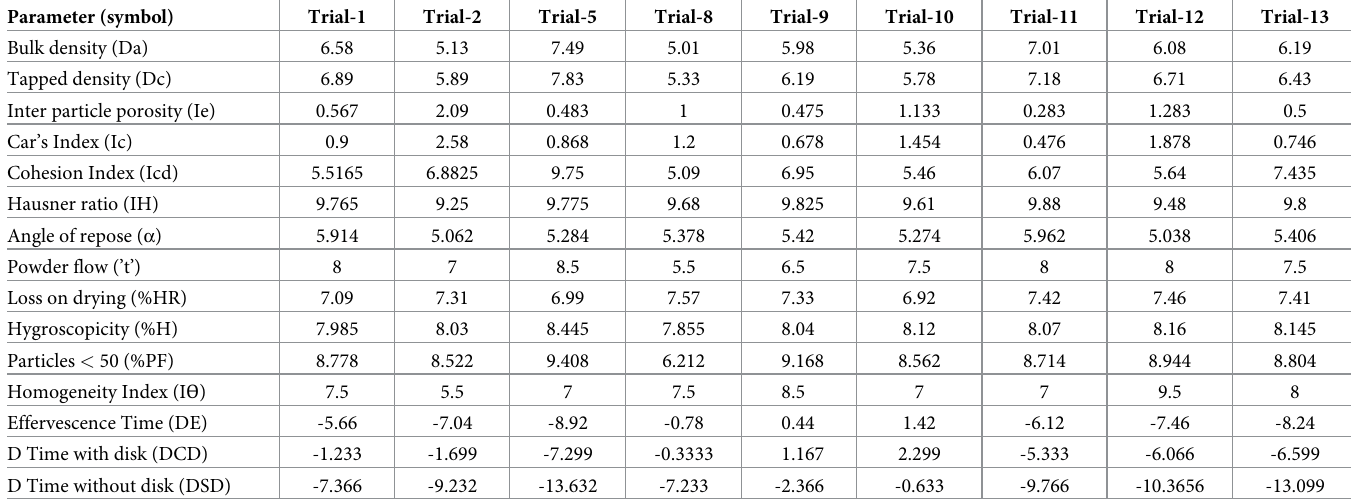
Table 5. The “r” values of granules prepared under different process variables (granulation time and binder concentration) by high shear